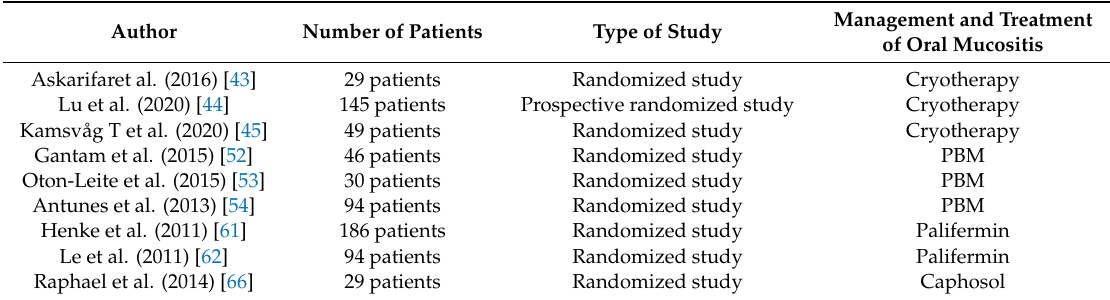
Table 5. Studies on cryotherapy, photobiomodulation (PBM), and usage of palifermin or